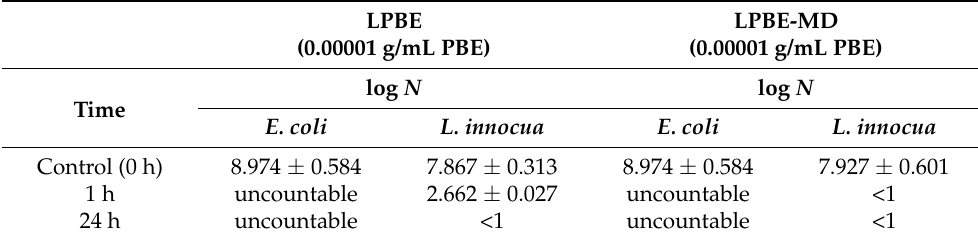
Table 2. Antimicrobial activity of non-encapsulated (LPBE) and encapsulated (LPBE-MD) PBE against Escherichia coli and Listeria innocua.